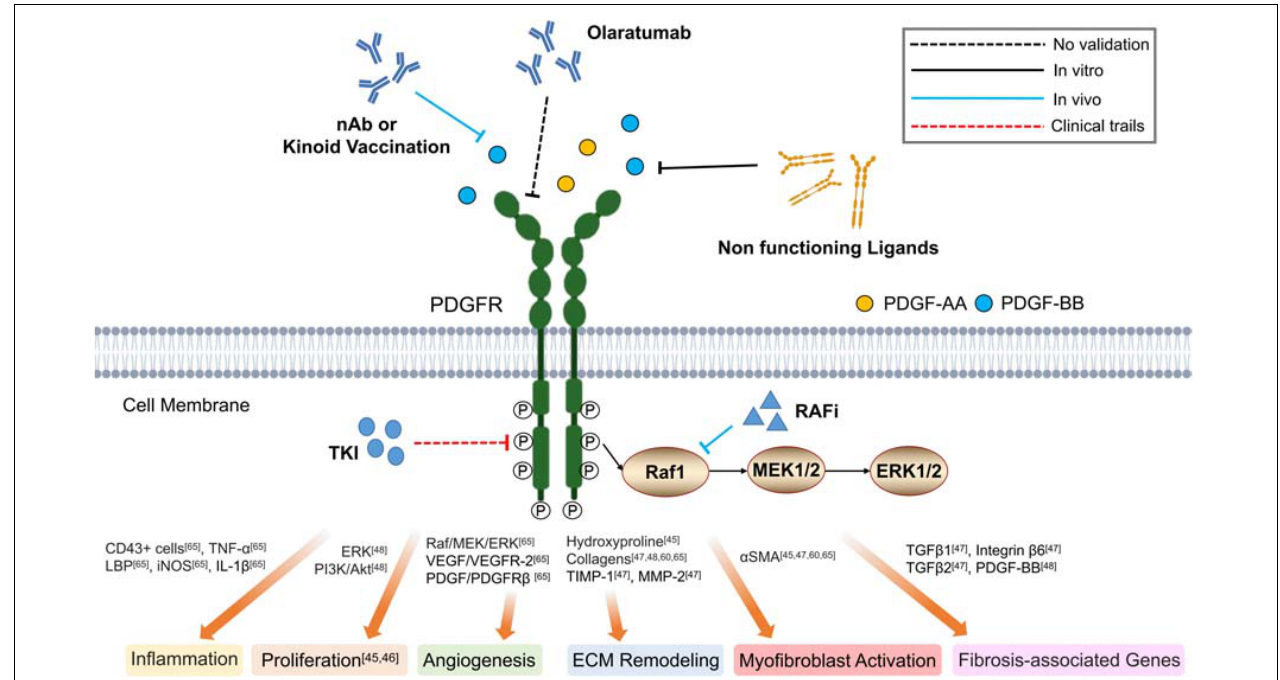
FIGURE 2 | Schematic graph showing potential antifibrotic therapies targeting PDGFR. (nAb, neutralizing antibody; TKI, tyrosine kinase inhibitor; RAFi, Raf kinase inhibitor; LBP, lipopolysaccharide-binding protein; TNF- α , tumor necrosis factor- α ; iNOS, inducible nitric oxide synthase; IL-1 β , interleukin-1 β ; PI3K, phosphoinositide 3-kinase; Akt, also known as PKB, protein kinase B; VEGF, vascular endothelial growth factor; VEGFR-2, vascular endothelial growth factor receptor-2; TIMP-1, tissue inhibitors of metalloproteinases-1; MMP-2, matrix metalloproteinase-2; α SMA, α -smooth muscle actin; ECM, extracellular